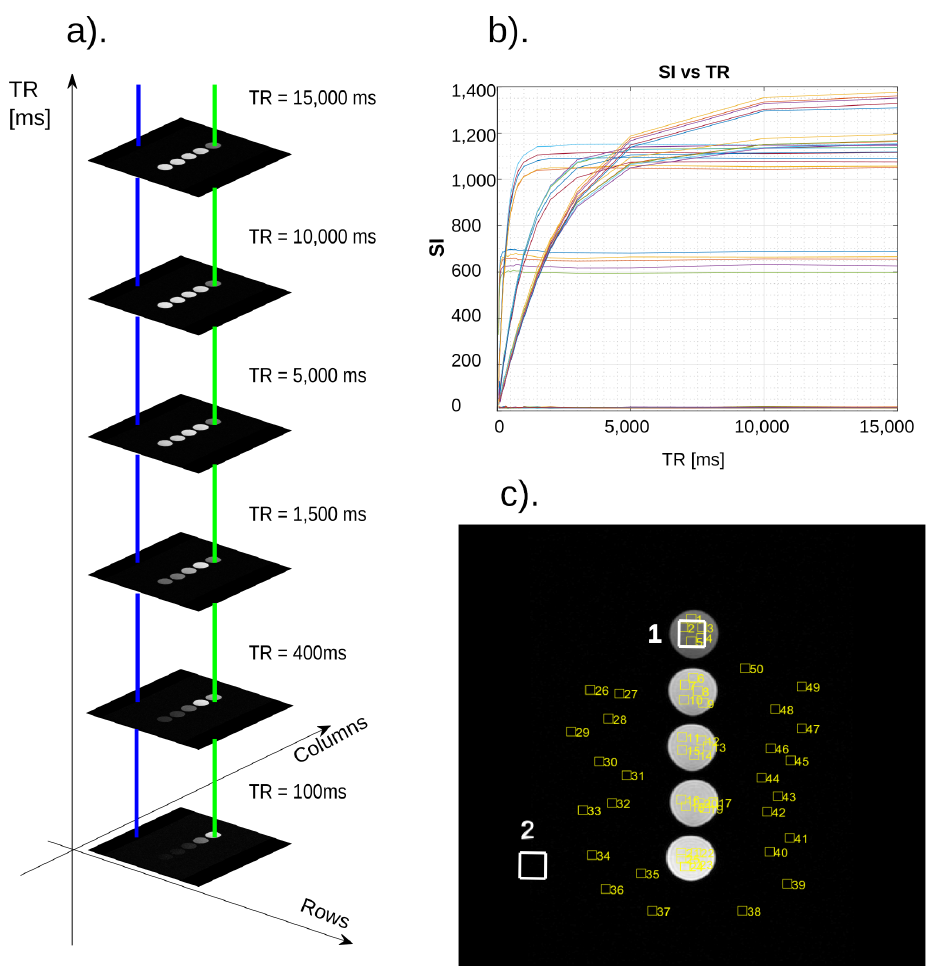
Figure 9. Panels ( a – c ) shows the method of acquiring data from a series of DICOM images for the stage of training the neural network. ( a ) Two colored lines passing through the image areas visually show where and how the data are collected. ( b ) The SI graphs in the TR function show the waveforms of the function describing the longitudinal relaxation time T 1 –these are real data obtained as a result of scanning the samples. ( c ) Selected scan–white markings refer to the places of data download for neural network training, yellow numbers are the points shown in ( b ). For the sake of accuracy, it should be added that the graphs of the noise values are located close to the horizontal axis, which makes them slightly emphasized in the scale of the graph. The task of the neural network was to segment the image in such a way that only the area of the tested object remained for calculations. Downloaded data are slices of images with a side of 10 pixels. As a result of this operation, two sets of data were obtained, which from the point of view of the MATLAB program, were matrices with dimensions [x,y,z], where x and y are the dimensions of the sample, while z is the number of analyzed series that were made during the study to determine individual times T 1 and T 2 . Each data